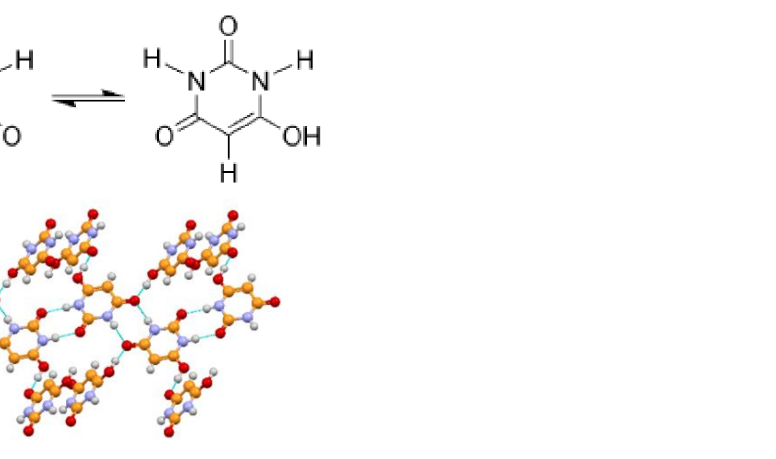
Figure 9. ( Top ): keto/enol tautomerism of barbituric acid; ( bottom ): crystal structure at room temperature of the enol form.